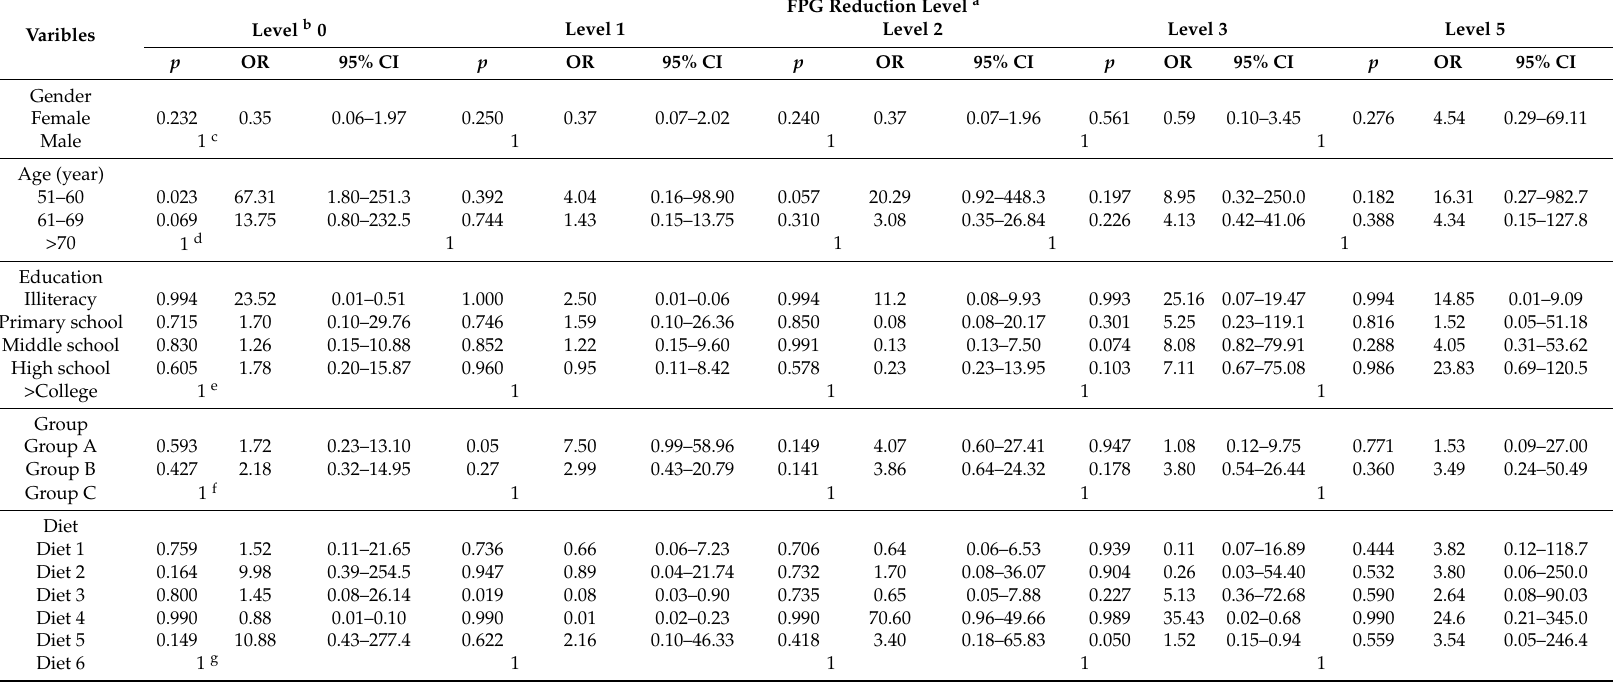
Table 8. Analysis of the associations between FPG declined and different